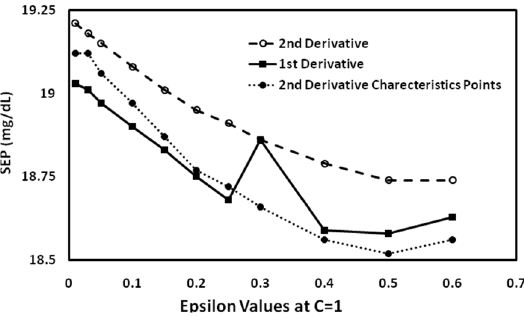
Figure 11. SEP of different Support Vector Regression (SVR) models against the ε values. Table 4. Comparison of performances of different SVR models.